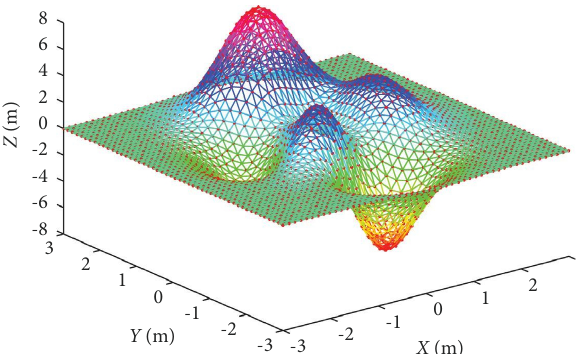
Figure 10: Diagram of unstructured